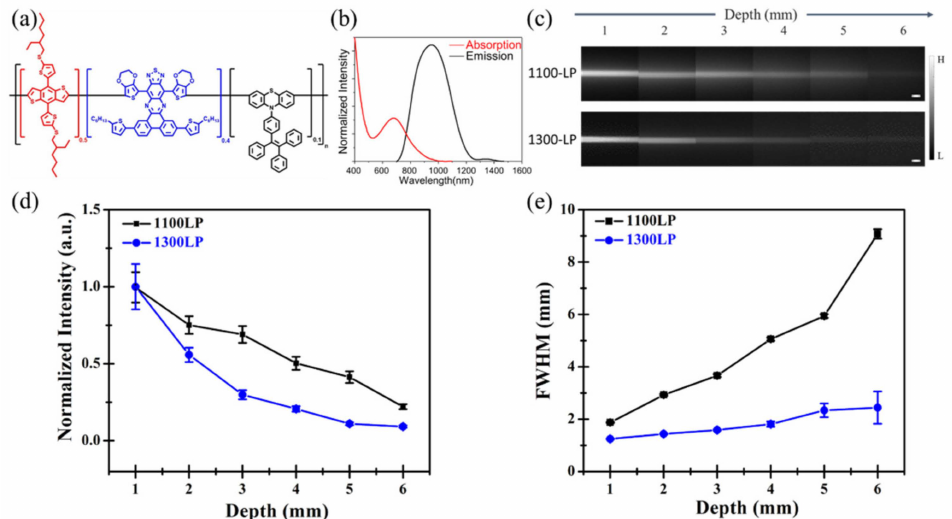
Figure 3. Intralipid ® phantom study of IR-TPE Pdots in NIR-II window. ( a ) Chemical structures of IR-TPE Pdots. ( b ) Absorption (red line) and fluorescence (black line) spectra of IR-TPE Pdots ( c ) Fluorescence images of glass capillaries filled with IR-TPE Pdots (scale bar, 2 mm), ( d ) quantifica- tion results, and ( e ) wavelength-dependent FWHM were calculated for capillary glass tubes filled with IR-TPE Pdots at varying depths. Data derive from mean ± SD. n = 3 independent